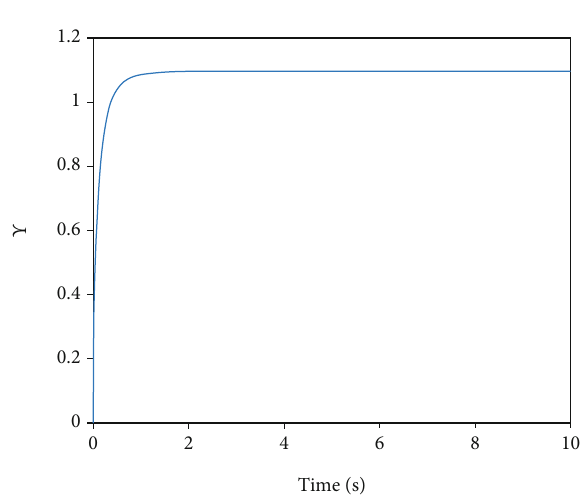
Figure 8: The response of attenuation performance of proposed